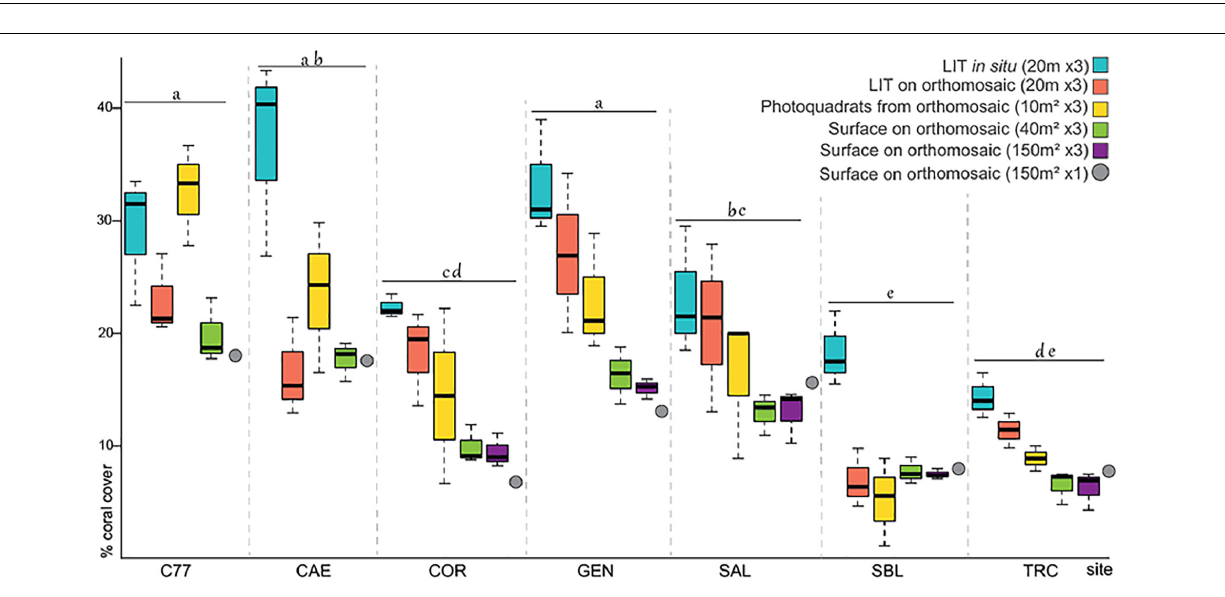
FIGURE 4 | Percent coral cover by method across sites. Same letters (a, b, c, d or e) in top of boxplots/site means no significant differences between groups (two-way ANOVA and Tukey test p <